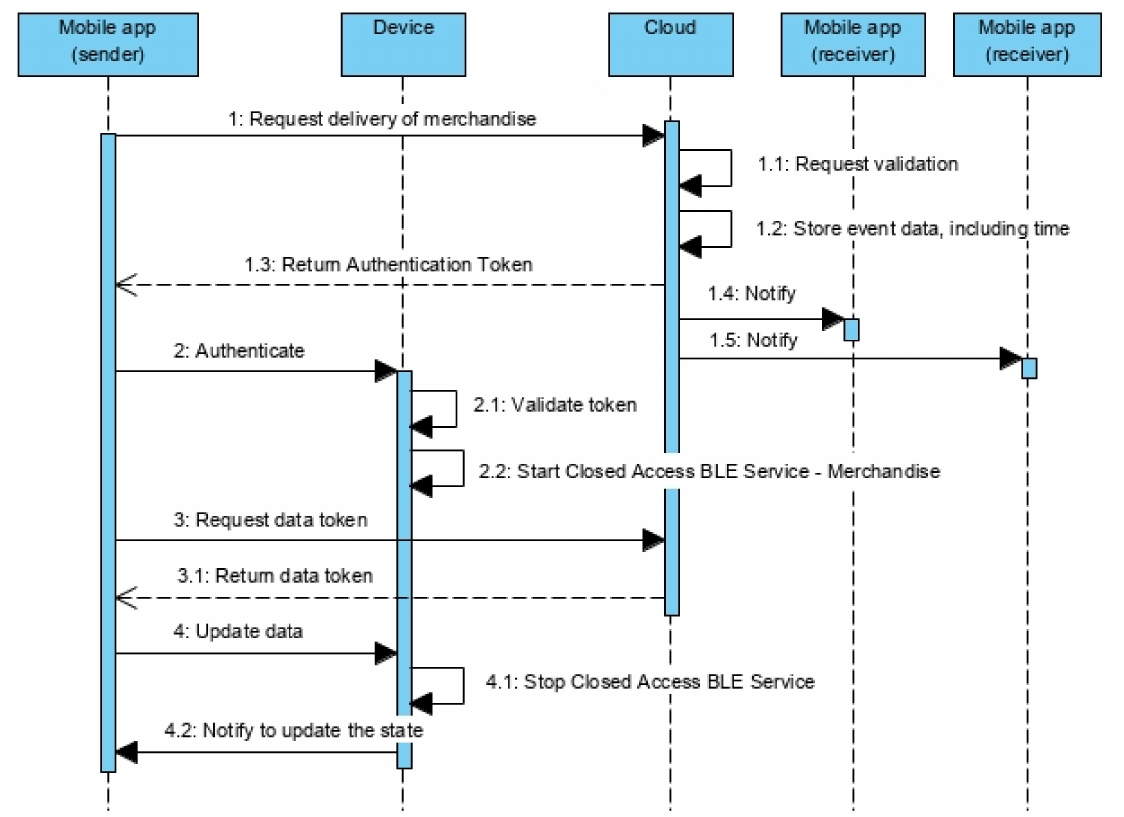
Figure 7. Merchandise deliver